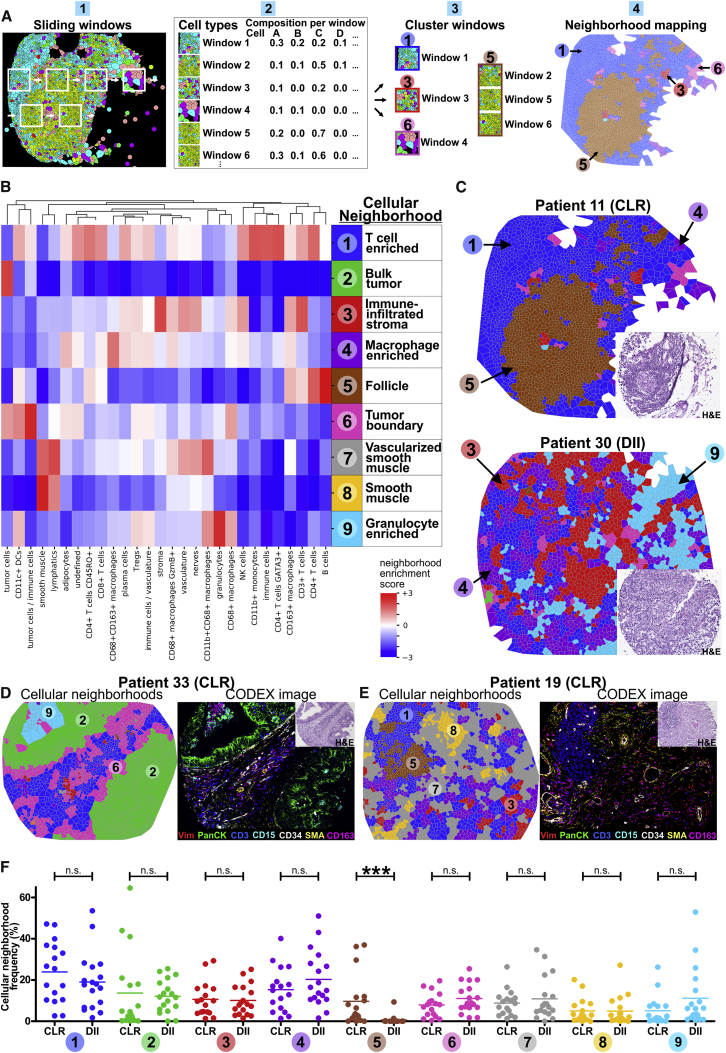
Characteristic CNs of the CRC iTME(A) Schematic of CN identification.(B) Identification of 9 distinct CNs based on the 28 original CTs and their respective frequencies (enrichment score) within each CN (pooled data from both patient groups).(C) Representative Voronoi diagrams of CNs for CLR and DII patients. Insets, H&E images.(D and E) Representative Voronoi diagrams of CNs were selected to show the nine different CNs (left panels) and corresponding seven-color images (right panels) in patient 33 (D) and 19 (E). Insets, H&E images.(F) Frequencies of CNs in CLR versus DII patients. Each point represents the mean CN frequency from four TMA cores per patient, and horizontal lines represent the means across patients (∗∗∗p < 0.001, Student’s t test).See also Figures S4C and S4D and Data S2D–S2G.